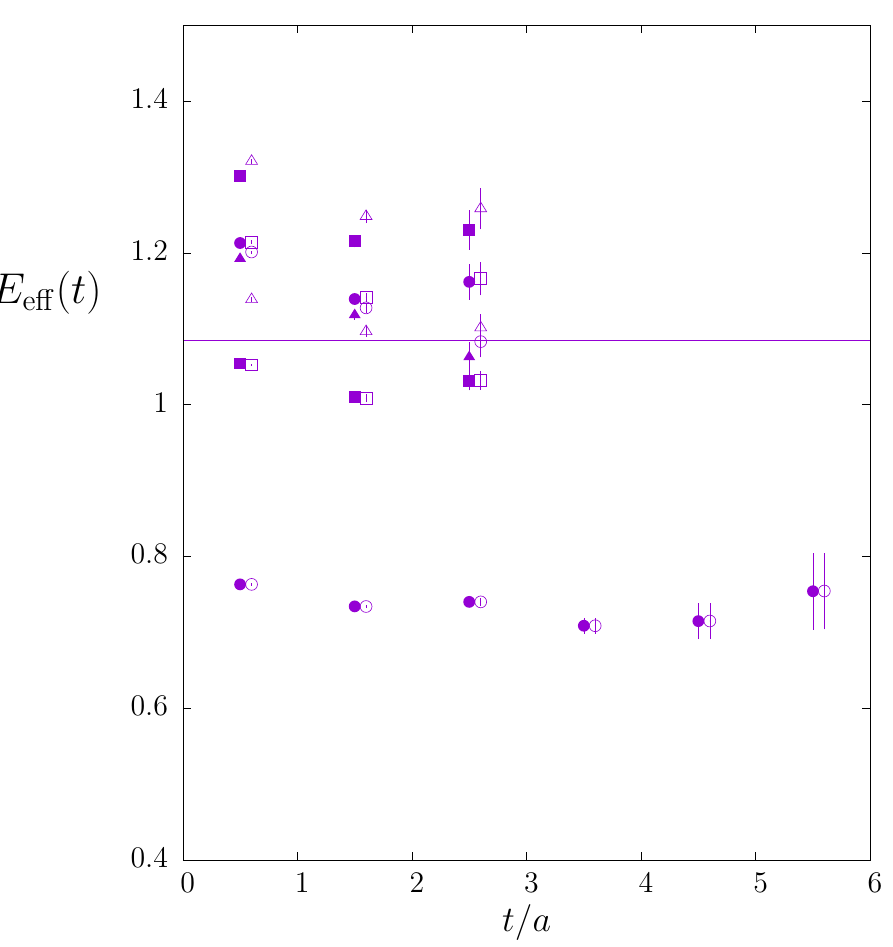
Figure 6 . Effective energies of the lightest E ++ states from the basis of the usual single loop operators (filled points) and from the same basis but extended with our ditorelon operators (unfilled points). Horizontal line is the energy of the lightest ditorelon state neglecting interactions between the torelons. On a 26 3 26 lattice at β = 6 . 235